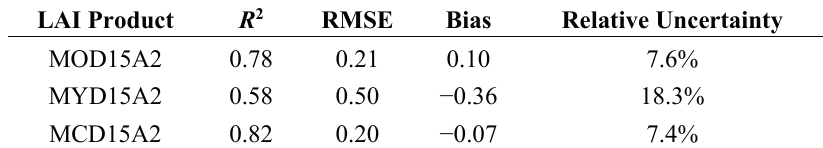
Figure 12. Comparison between the mean MODIS LAI values and the mean of the LAI reference maps at Huailai site from 4 July to 28 August 2013. Table 2. The accuracy of the MODIS LAI products at Huailai